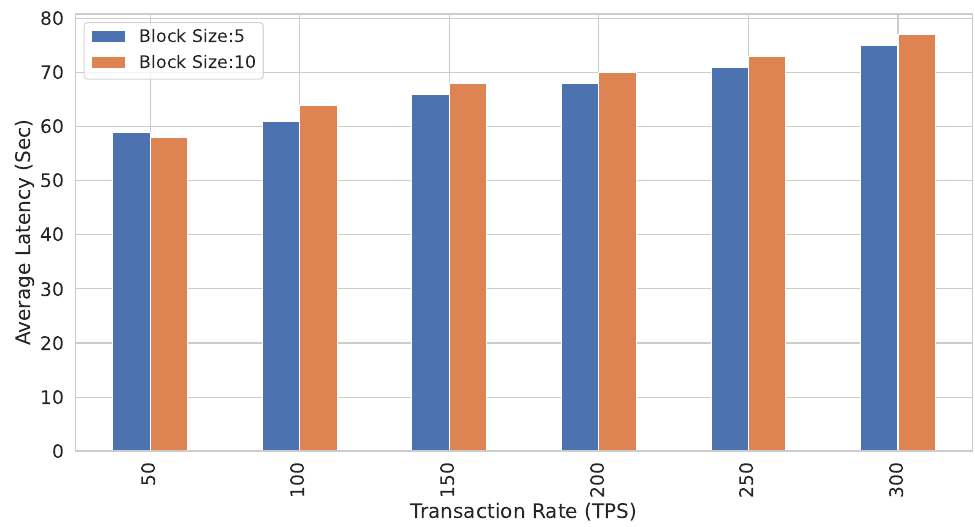
Figure 19. Average latency with varying transaction rate for different block